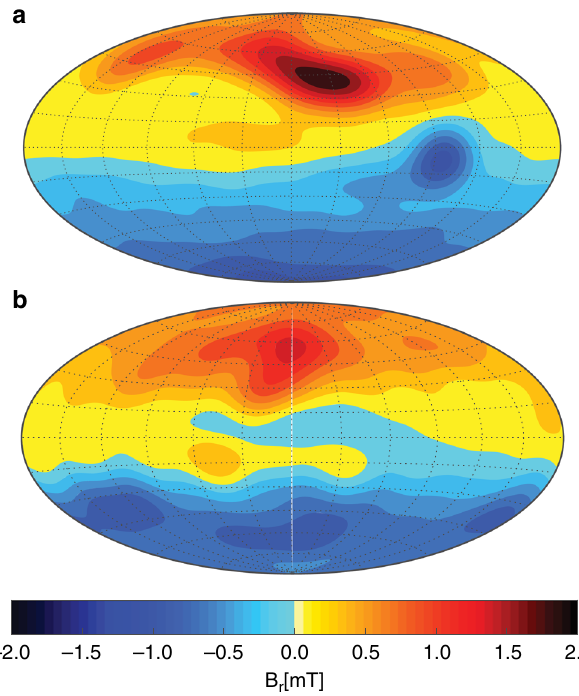
Fig. 2 The magnetic fi eld of Jupiter. a Jupiter's radial surface fi eld model JRM09 based on Juno measurements 3 . b Snapshot of the radial surface fi eld in a Jupiter-like dynamo simulations 10 . Outgoing fi eld is shown in yellow and red and ingoing fi eld in